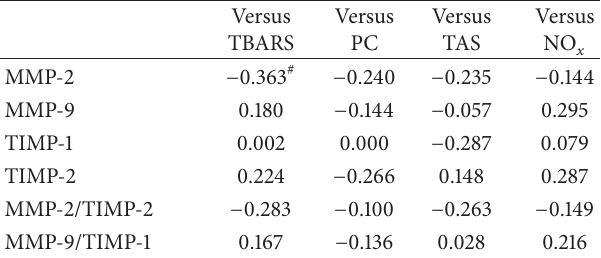
Table 4: Correlations between oxidative parameters and gelatinases in diabetic MS subjects.